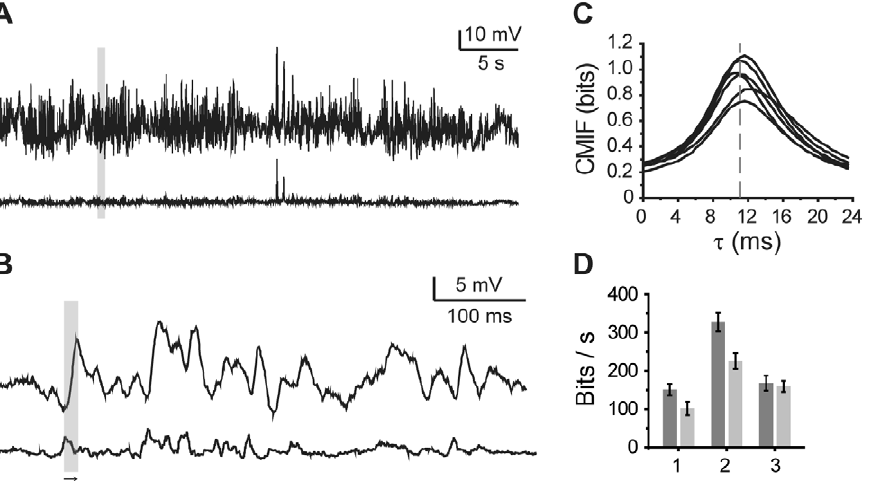
Figure 3. Information processing in blowfly photoreceptors. A , An example of the photoreceptor response (top) to the light stimulus (below; stimulus 2 in D ). B , Enlargement of the section marked with the grey box in A ; output follows the input with a delay of ca. 11 ms (grey box). C , CMIFs from six photoreceptors; delay observed in B is marked with the grey dashed line. D , Mean 6 s.d. of the information rates (grey) and information capacities (light grey) for three different stimulus sequences (significantly different in each case; Student’s t-test; (1) p , 0.00031, (2) p , 0.000011 and (3) p , 0.048).